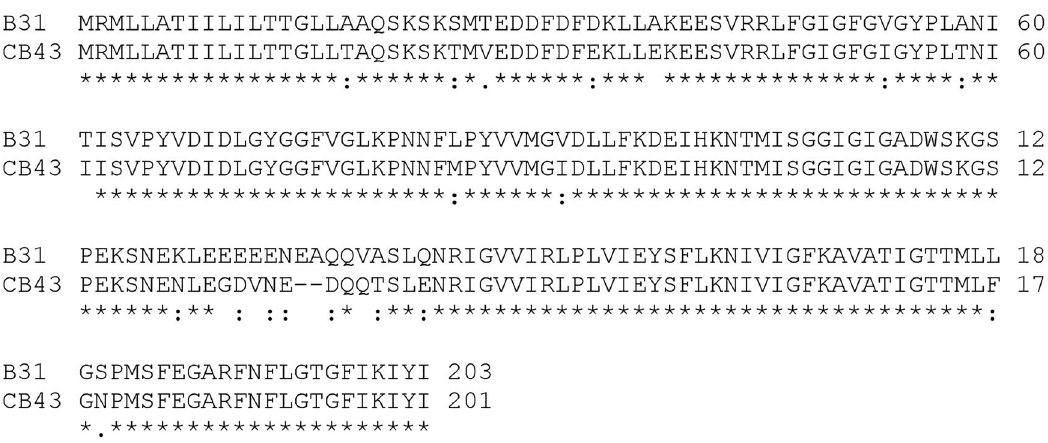
Figure 1. Alignment between the BB0405 protein sequence between Borrelia burgdorferi B31 and Borrelia afzelii PKO. Borrelia burgdorferi B31 corresponds to NCBI Reference Sequence: NP_212539. Borrelia afzelii PKO is identical to CB43 (GenBank: CP002933.1 translated in ExPASy translate tool). Identity between sequences is 88.2%. Additionally there are 17 similar positions bringing the similarity to 96.5%. Alignment was performed with Clustal Omega. * = identical, : =